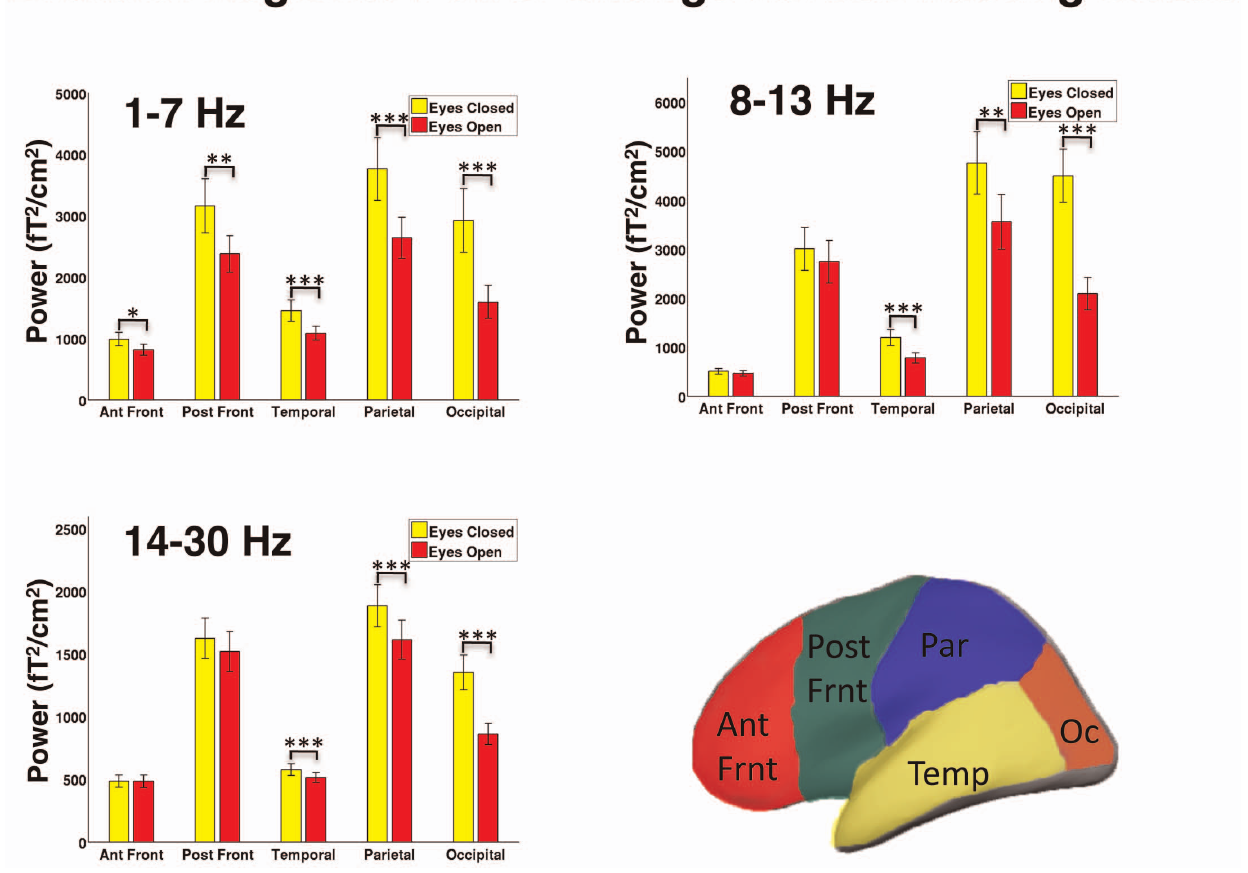
Figure 3. Regional and condition power analyses. Repeated measures ANOVA showing power amplitude decreases from eyes closed to eyes open. Delta/theta band changes between the conditions are particularly pronounced, and significant for all bands. Alpha power also had significant power decreases in the temporal lobes and posterior aspects of the brain. Similarly, beta group analysis showed significant power decreases in the temporal, parietal, and occipital lobes. A representative diagram is displayed of sensor-based separation of brain regions. aFr=anterior frontal cortex, pFr=posterior frontal cortex, Par=parietal cortex, Temp=temporal cortex, Oc=occipital cortex. *=p , 0.05, **=p , 0.01, ***=p , 0.001.